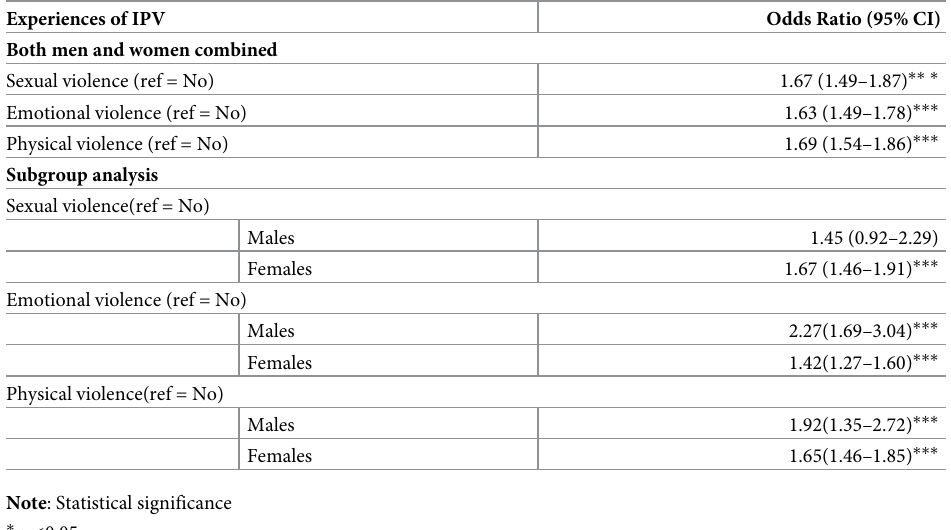
Table 4. Odds ratio estimates of the effect of justification of wife-beating on experiences of different forms of